Question: Which kind of chart has been used to present this data?
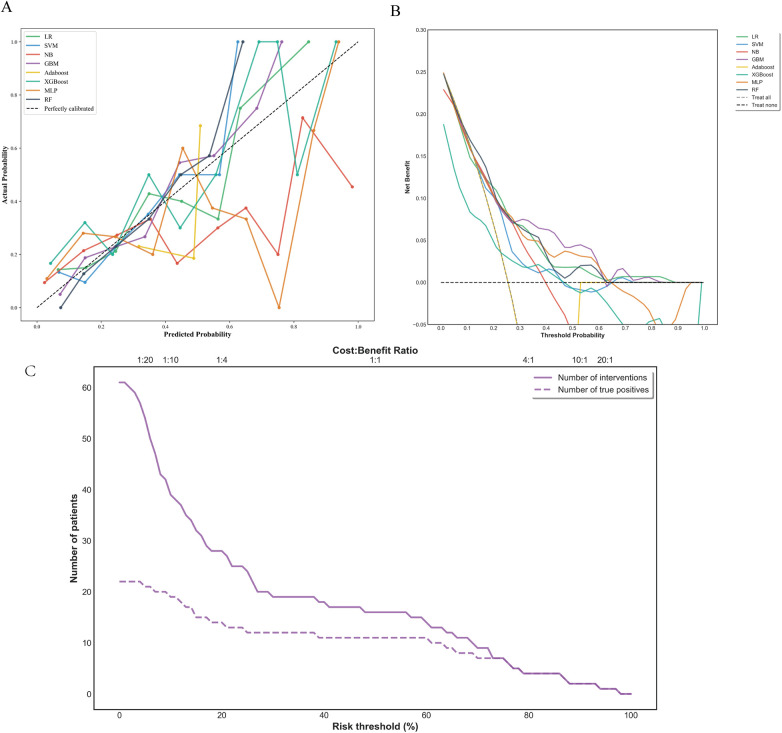
Answer: line